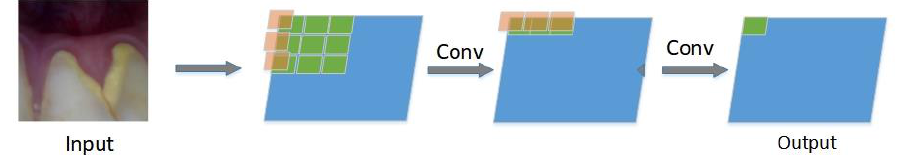
Figure 6. Asymmetric convolution process .